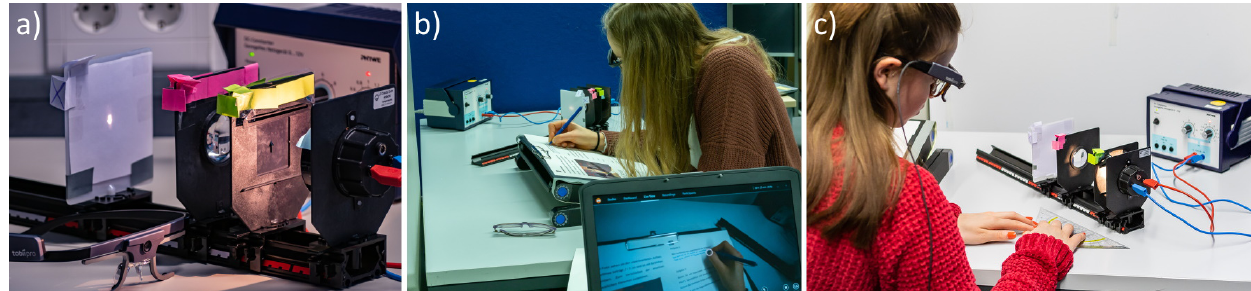
Figure 2. ( a ) Experimental setup; ( b ) An example of the study setup for participants with the experiment in the background, a participant working on the instructional material, and the computer monitor of the supervisor in the foreground; ( c ) a participant working with the